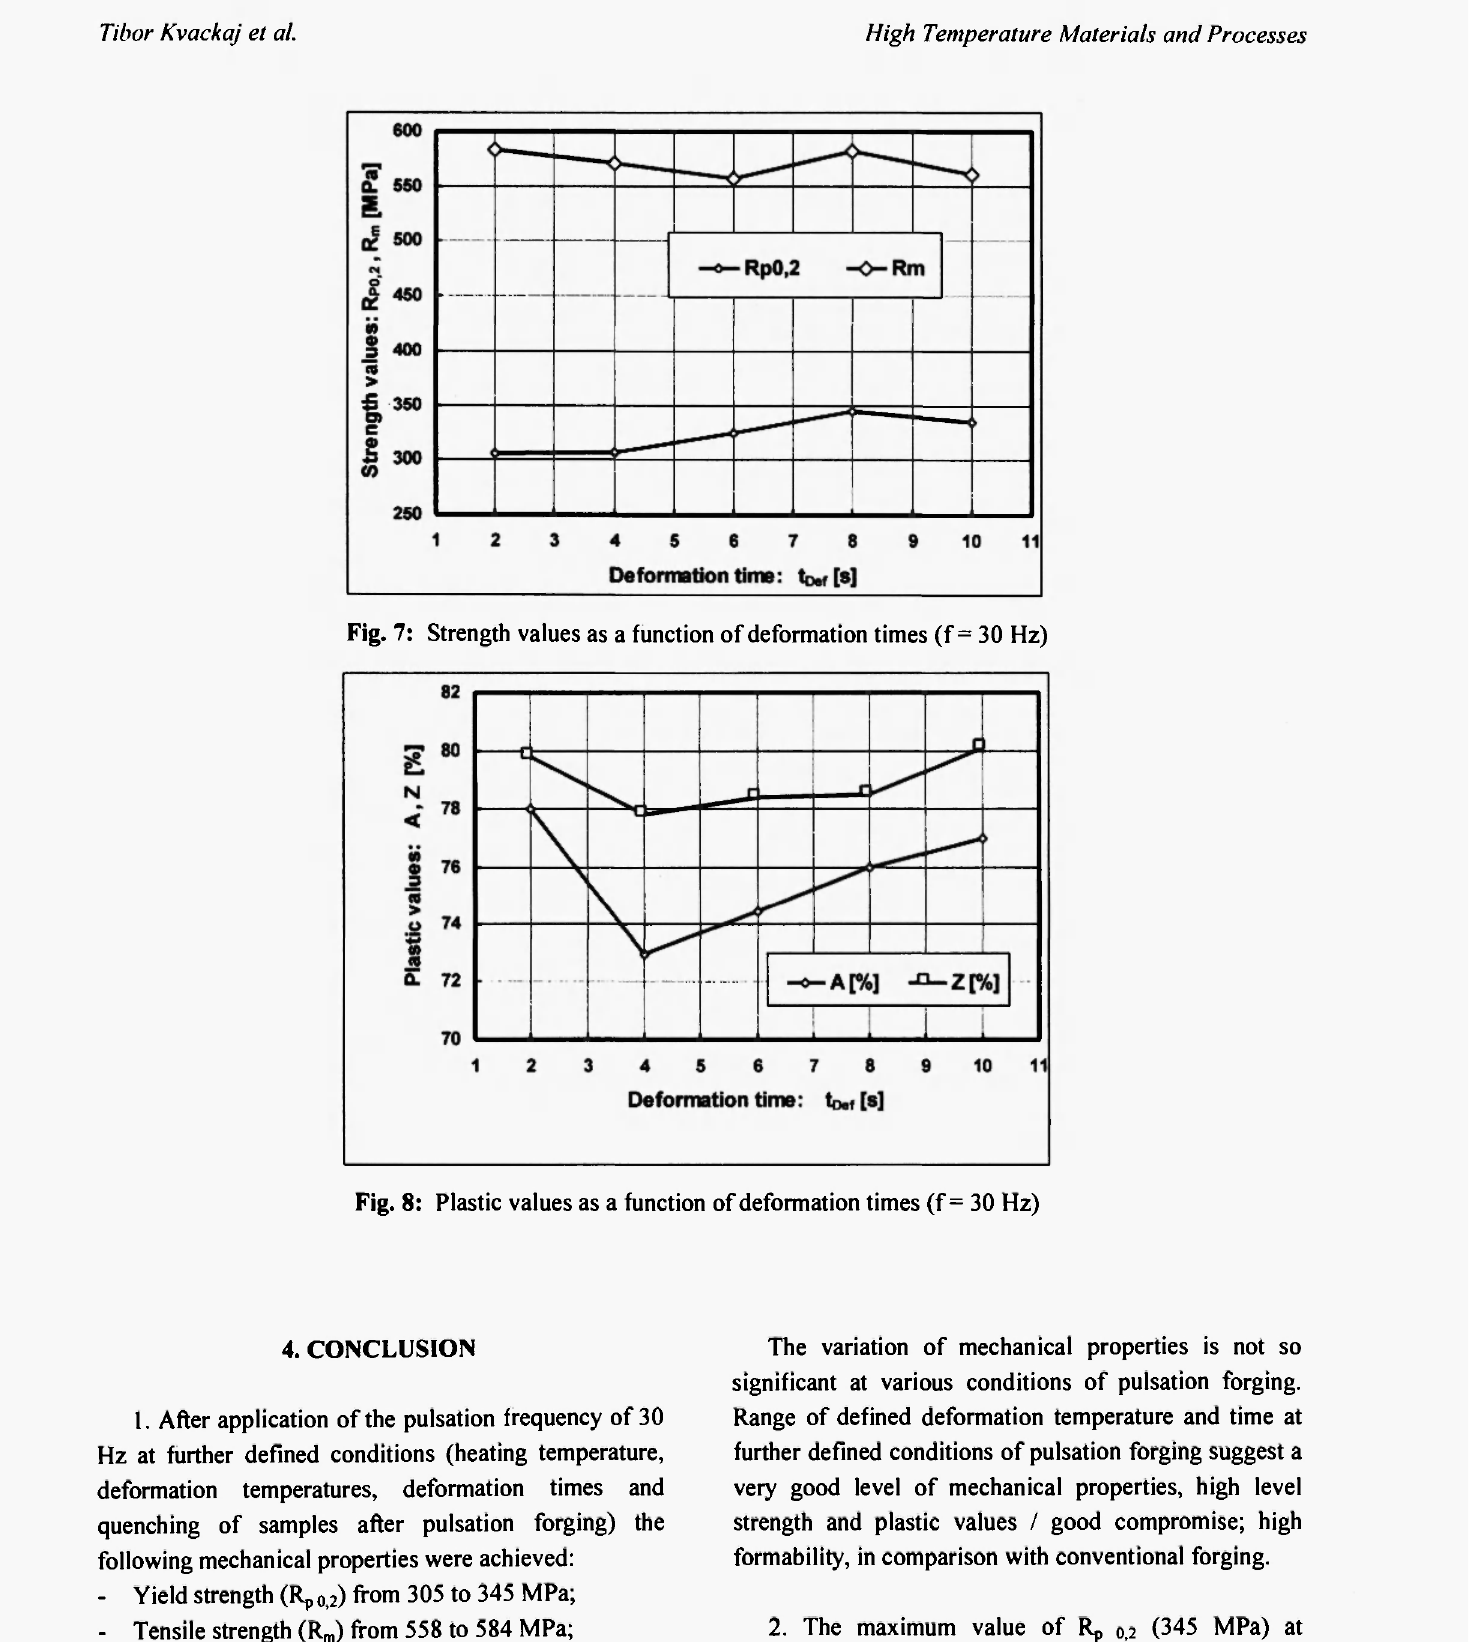
Fig. 8: Plastic values as a function of deformation times (f = 30